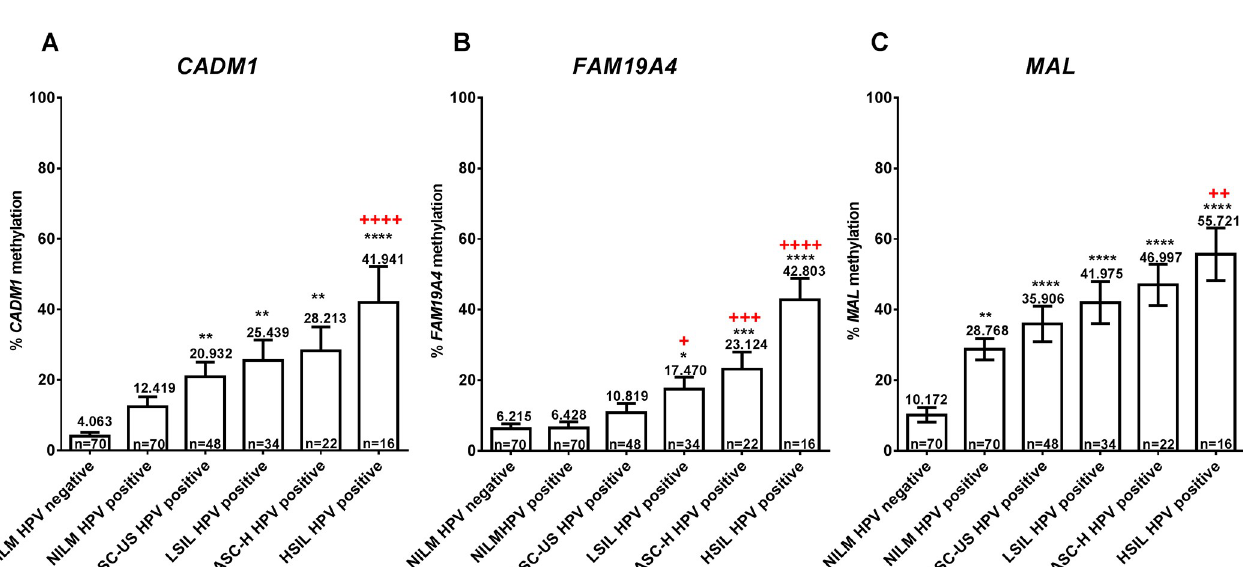
PLOS ONE | https://doi.org/10.1371/journal.pone.0210289 January 4,